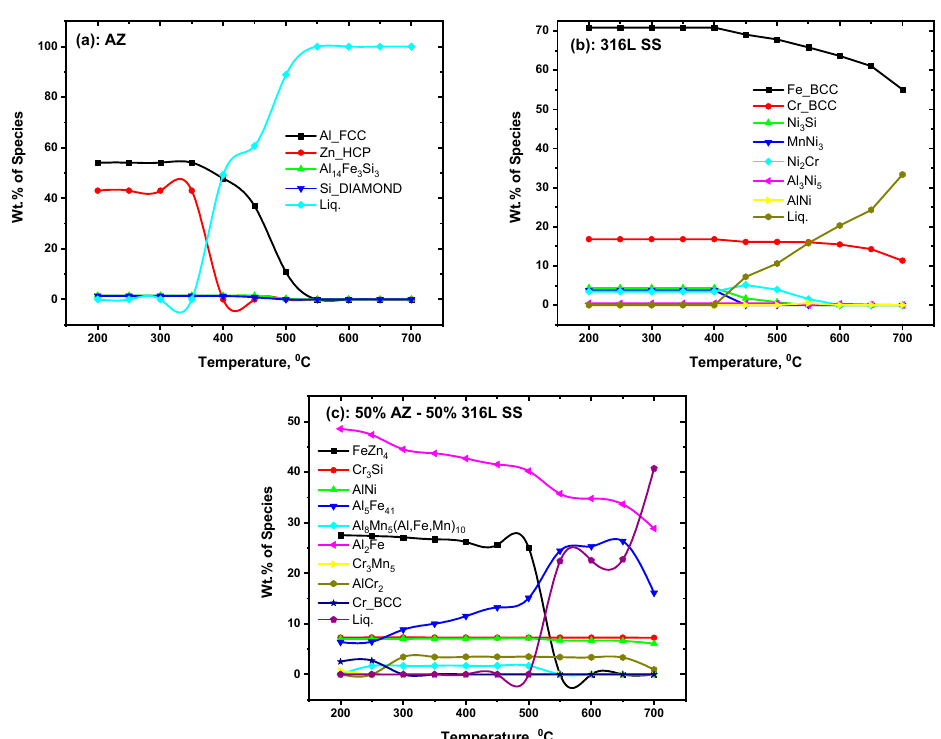
Figure 4. Equilibrium products and their compositions in the ( a ) AZ coating, ( b ) SS base metal and ( c ) at the interface of the base metal and the coating (optimized for 50% AZ and 50% SS) at different processing temperatures ranging from 200 to 700 °C.